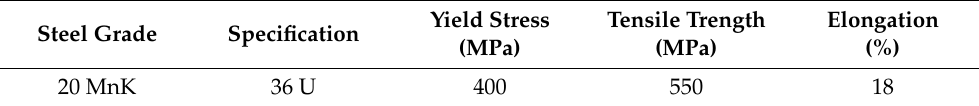
Table 2. Basic mechanical performance parameters of the U-shaped steel